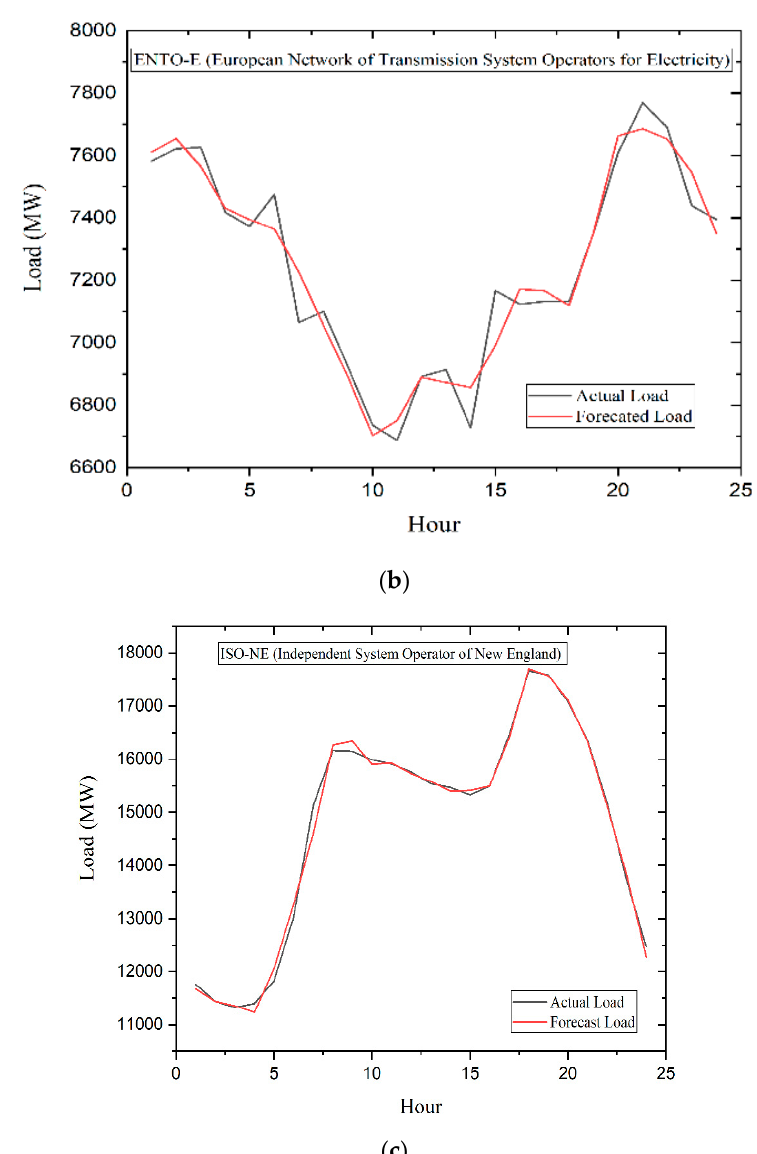
Figure 6. Forecast results of proposed model with three datasets: ( a ) IESO-Canada-Dataset; ( b ) ENTO-European-Dataset; ( c ) ISO-NE-Dataset.